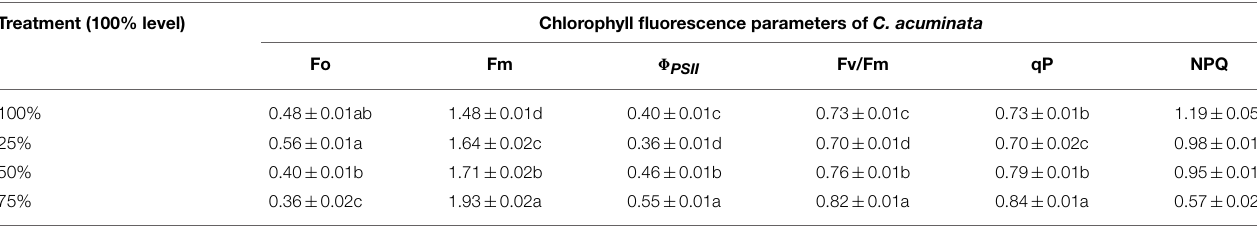
The values presented are the means ± SE. Different letters indicate significant differences between irradiance treatments (P < 0.05); n = 5. 100% level = 1500 ± 30 µ mol m − 2 s − 1 . Foindicates initial fluorescence; Fmisthemaximal fluorescence; 8 PSII isactual photochemical efficiency ofPSII,Fv/Fmisaratioofvariablefluorescence overthemaximumfluorescence value, qP is photochemical quenching, and NPQ is non-photochemical quenching.